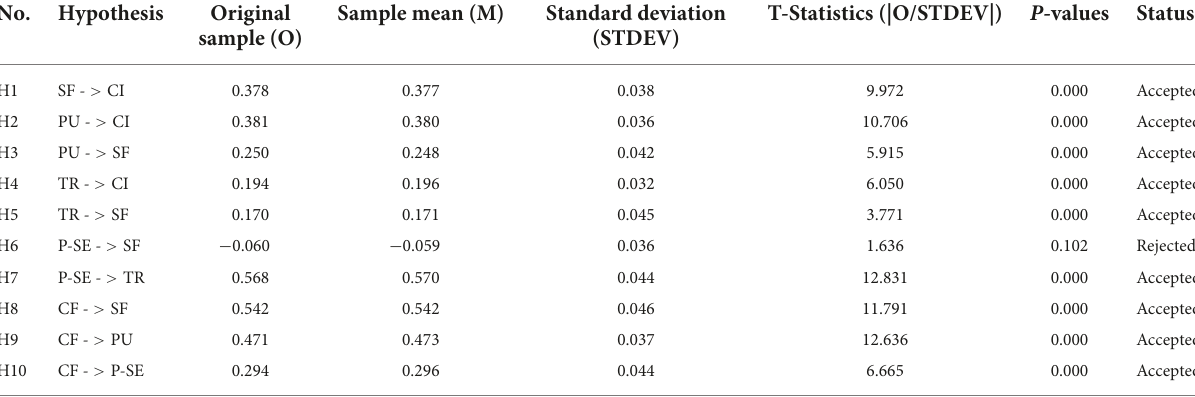
FIGURE2 Hypotheses test results.